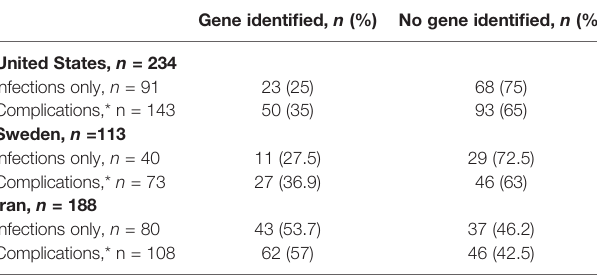
TABLE 1 | Monogenic defects identi fi ed in 3 CVID cohorts by phenotype (infections only vs. complications)